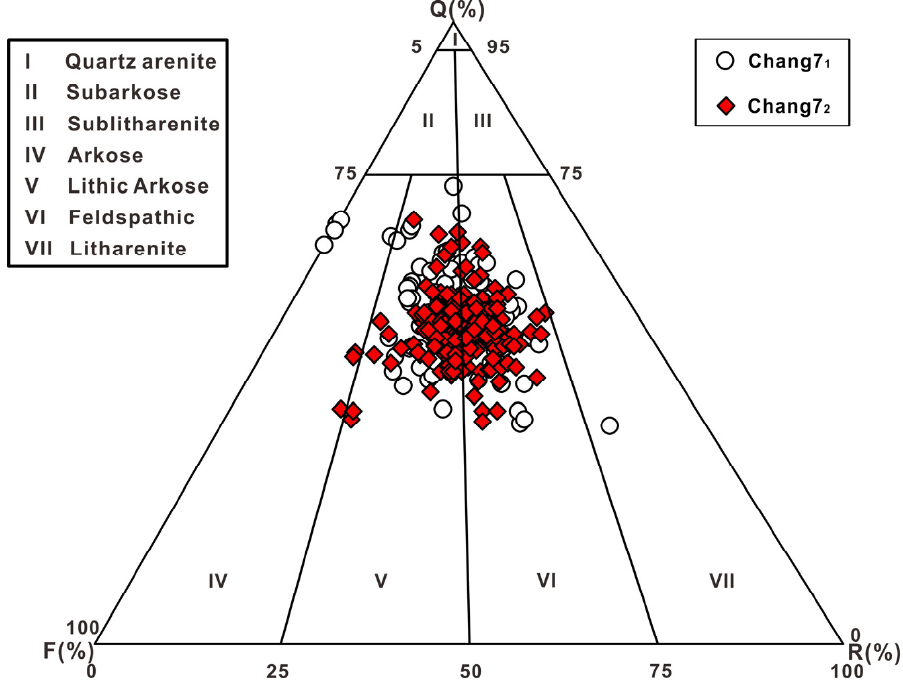
Figure 2. Ternary diagram of the grain composition of the Chang 7 1-2 shale oil reservoir in the Ordos Basin (Q: quartz, F: feldspar, R: rock fragment).